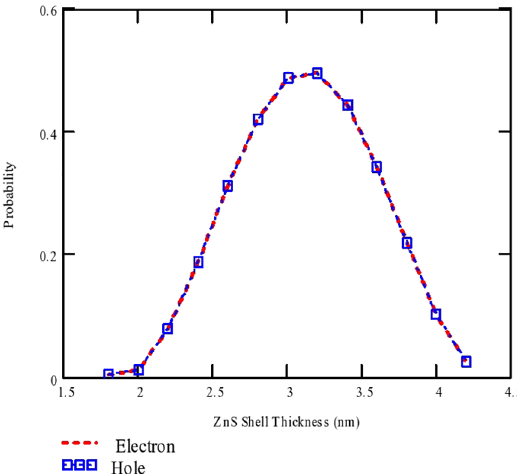
Figure 6. Electron and hole probability distribution in the lowest energy state in ZnSe/ZnS CSQD as a function of ZnS shell